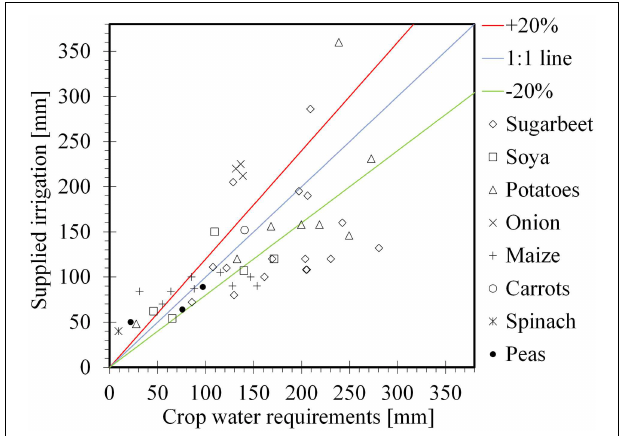
FIGURE 5 | Crop water requirements (CWR) vs. supplied irrigation volumes for Sugarbeet (number of irrigation units, n = 16 ), Soya ( n = 5 ), Potatoes ( n = 8 ), Onion ( n = 3 ), Maize ( n = 9 ), and other crops (Carrots, Spinach and Peas) ( n = 5 ).